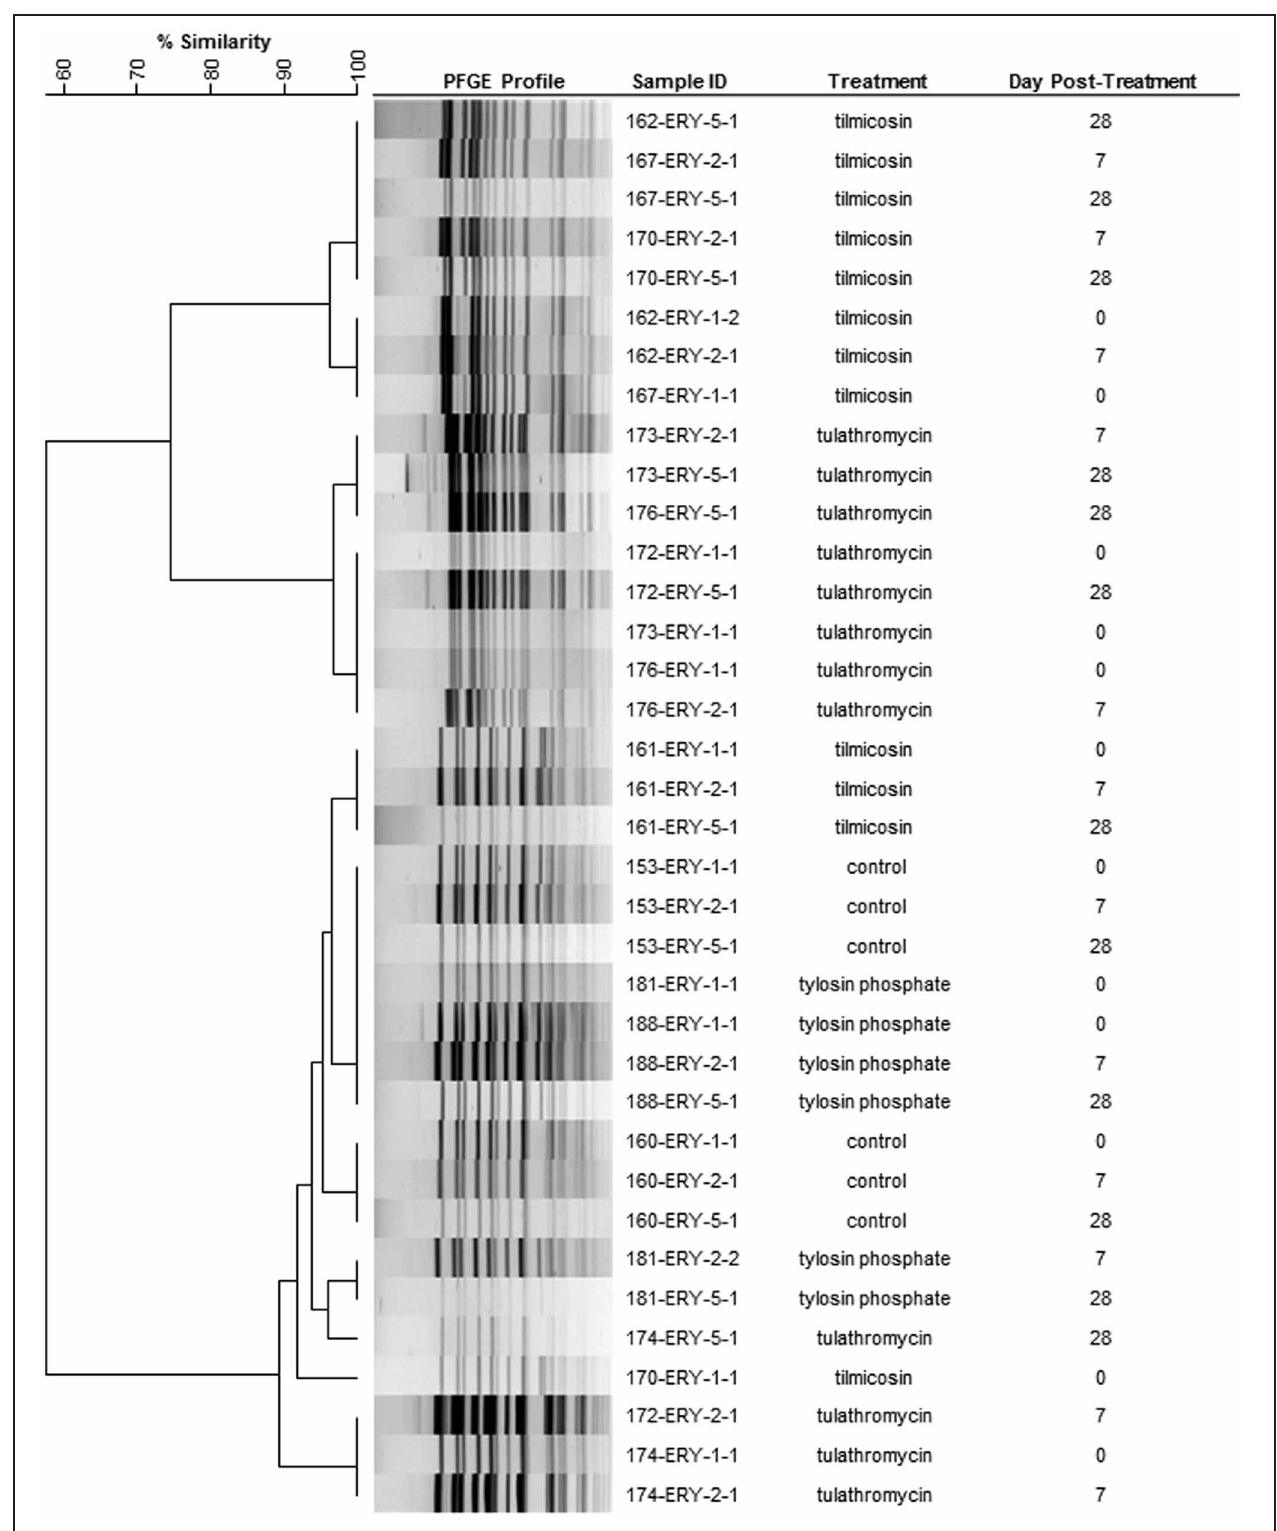
FIGURE 6 | Dendrogram of PFGE Sma I profiles from representative erythromycin resistant enterococci from day 0, 7, and 28. As an example, sample ID 153-ERY-5-1 represents isolate #1 collected from BEA + ERY plates